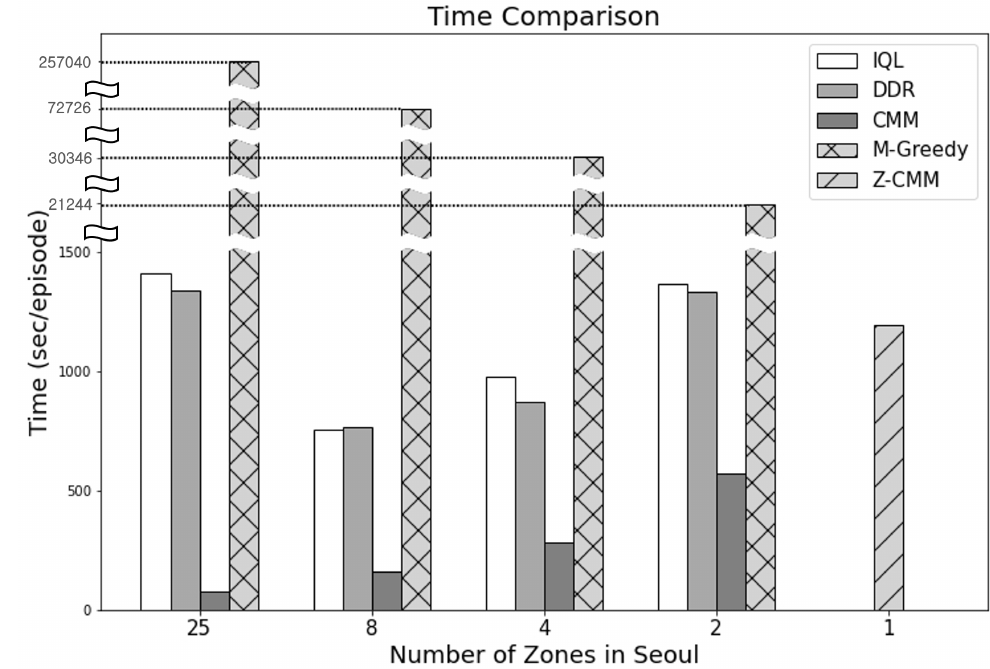
Figure 13. Illustrations of time consumption by each